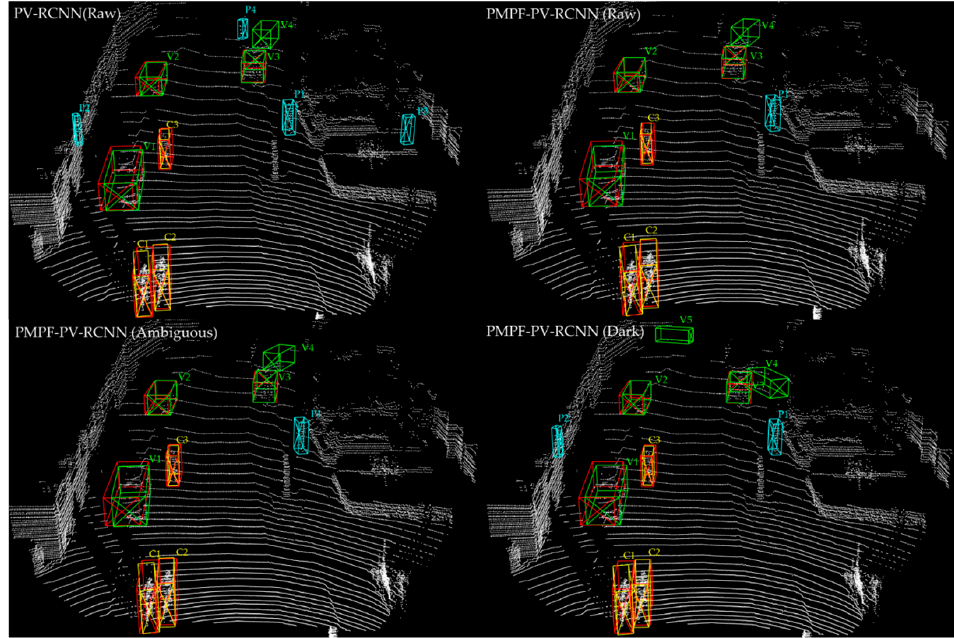
Figure 8. Qualitative comparison between PMPF under different image quality scenarios and PV- RCNN on the KITTI 3D object detection dataset. The figures are marked in the same way in Figure 5.